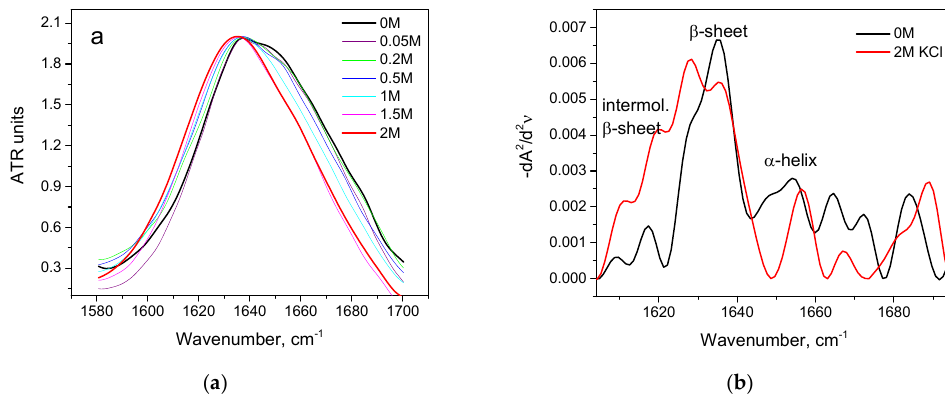
Figure 8. Changes in the Amide I band ( a ) and changes in the second derivative of the Amide I band ( b ) of trypsin in 20% wt. aqueous solution at 23 °C with various concentrations of KCl. Only the most representative curves are shown for the sake of clearness.